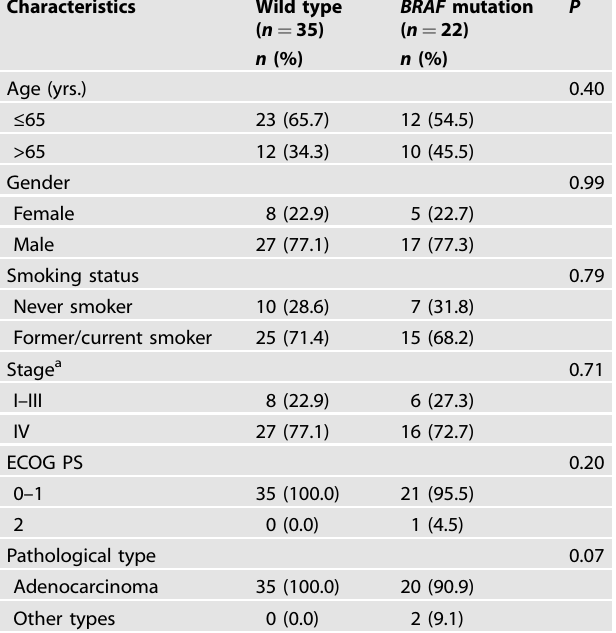
Table 1. Association of demographics and clinicopathological characteristics with BRAF mutation status in Cohort